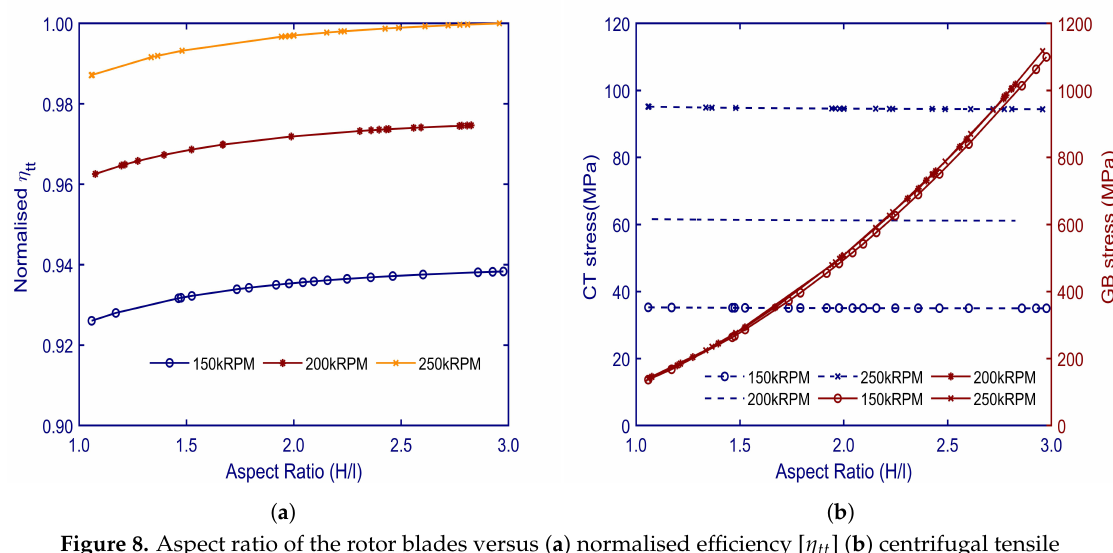
Figure 8. Aspect ratio of the rotor blades versus ( a ) normalised efficiency [ η tt ] ( b ) centrifugal tensile [CT] and gas bending [GB] stresses at various rotational